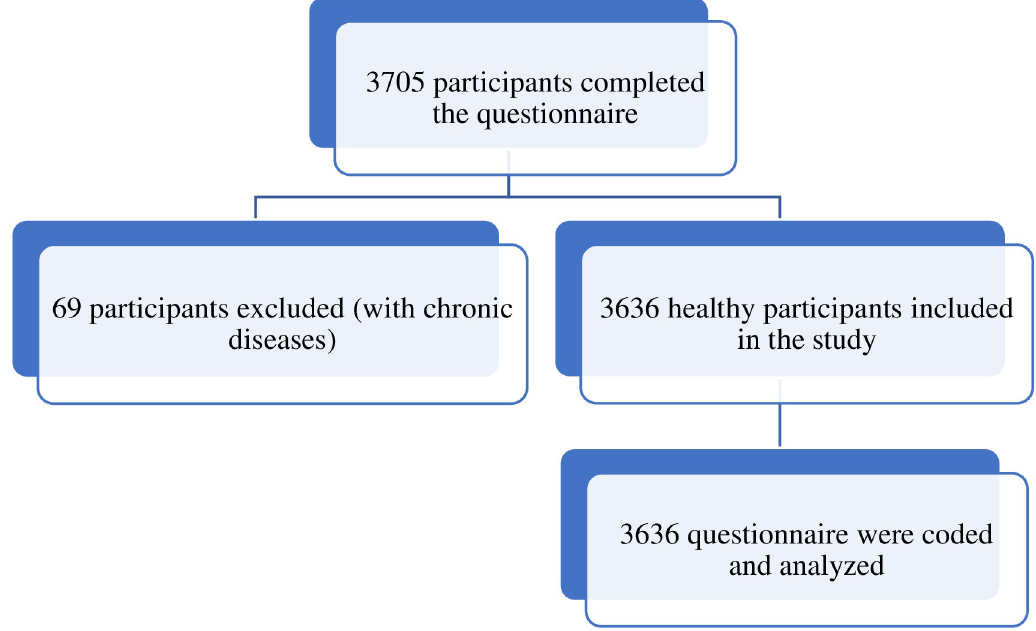
Fig 1. The recruitment of the athletes and coaches for nutrition knowledge